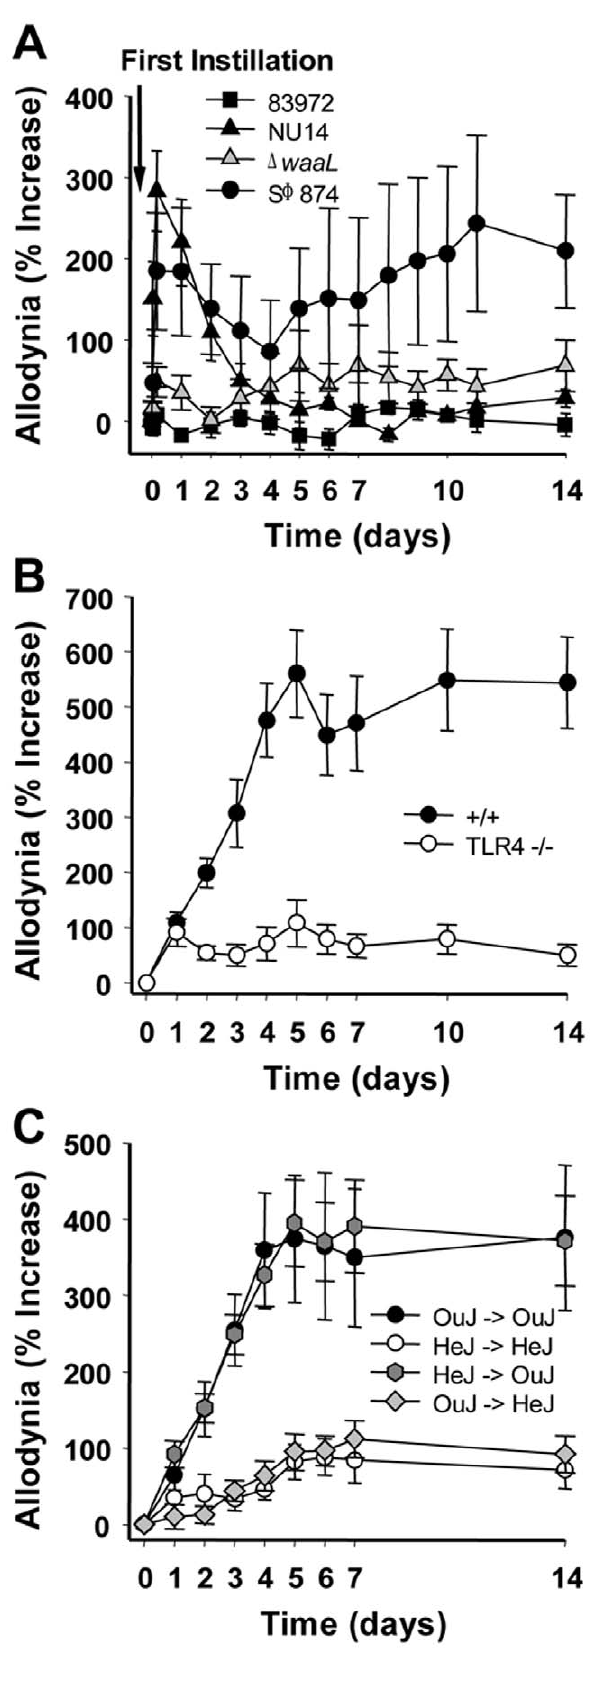
Figure 2. Purified LPS mimics effects of intact E. coli , and chronic pain is TLR4-dependent. ( A ) Mice (n=8) were instilled 25 m l of 2 m g/ml of LPS purified from NU14, 83972, D waaL , or S W 874 and then evaluated for pelvic allodynia. ( B ) S W 874-induced pain in + / + mice is reduced in TLR4 2 / 2 mice (n=5; P , 0.05 Days 4–14). ( C ) + / + mice (C3H/HeJOuJ, ‘‘OuJ’’) or TLR4-deficient mice (C3H/HeJ, ‘‘HeJ’’) were used as bone marrow donors for c -irradiated recipients; legend arrow indicates donor bone marrow into recipient (n=9, 9, 14 and 15 respectively). C3H/HeJOuJ recipients exhibited S W 874-induced pain that was reduced in C3H/HeJ recipients (P , 0.01 Days